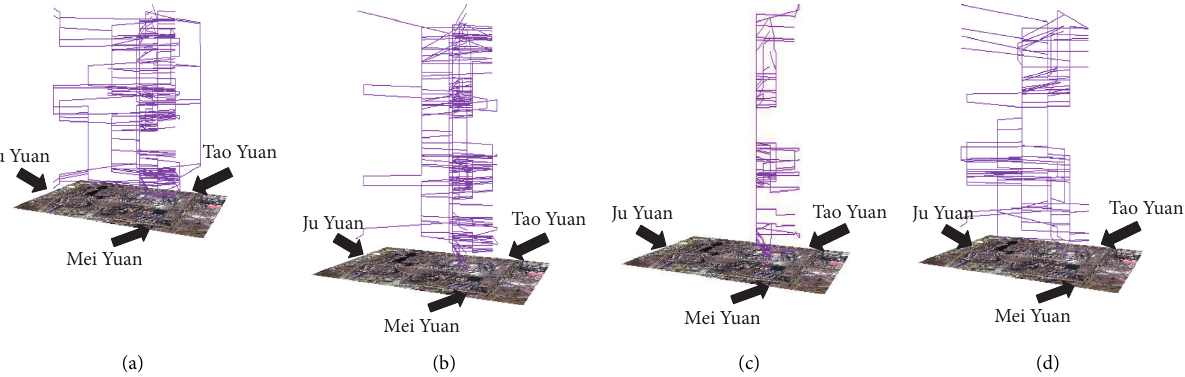
Figure 14: Weekday activity travel pattern classification. (a) Early return, (b) classroom+library, (c) classroom, and (d) diversity.